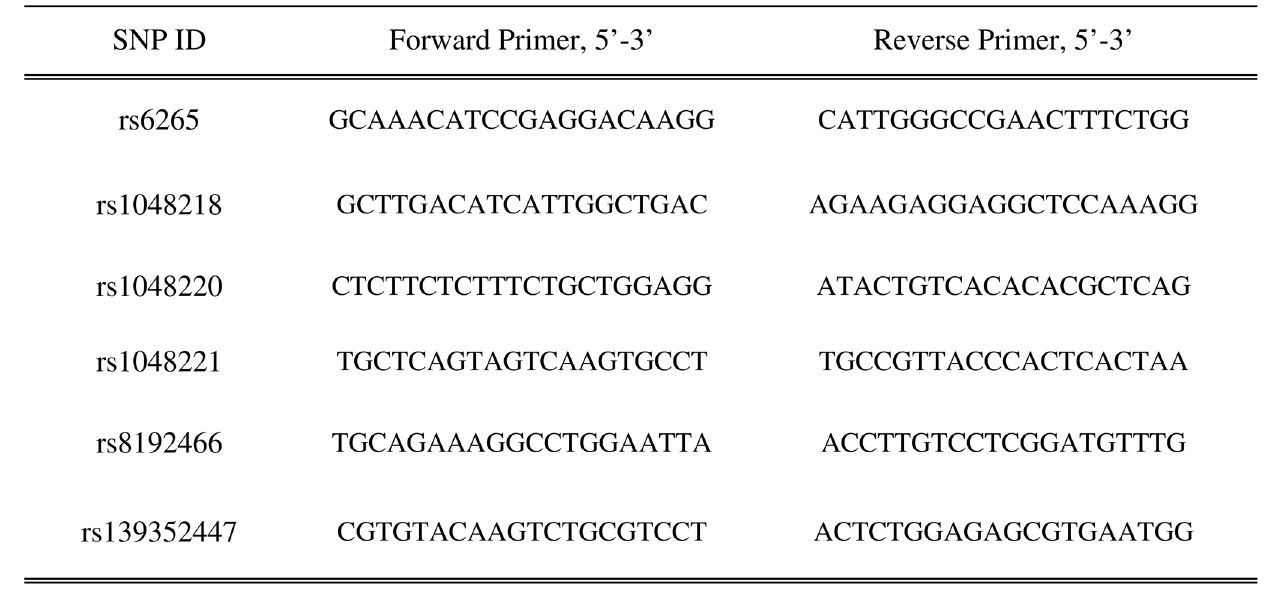
Fig 2. The primer sequences of 6 SNPs of BDNF